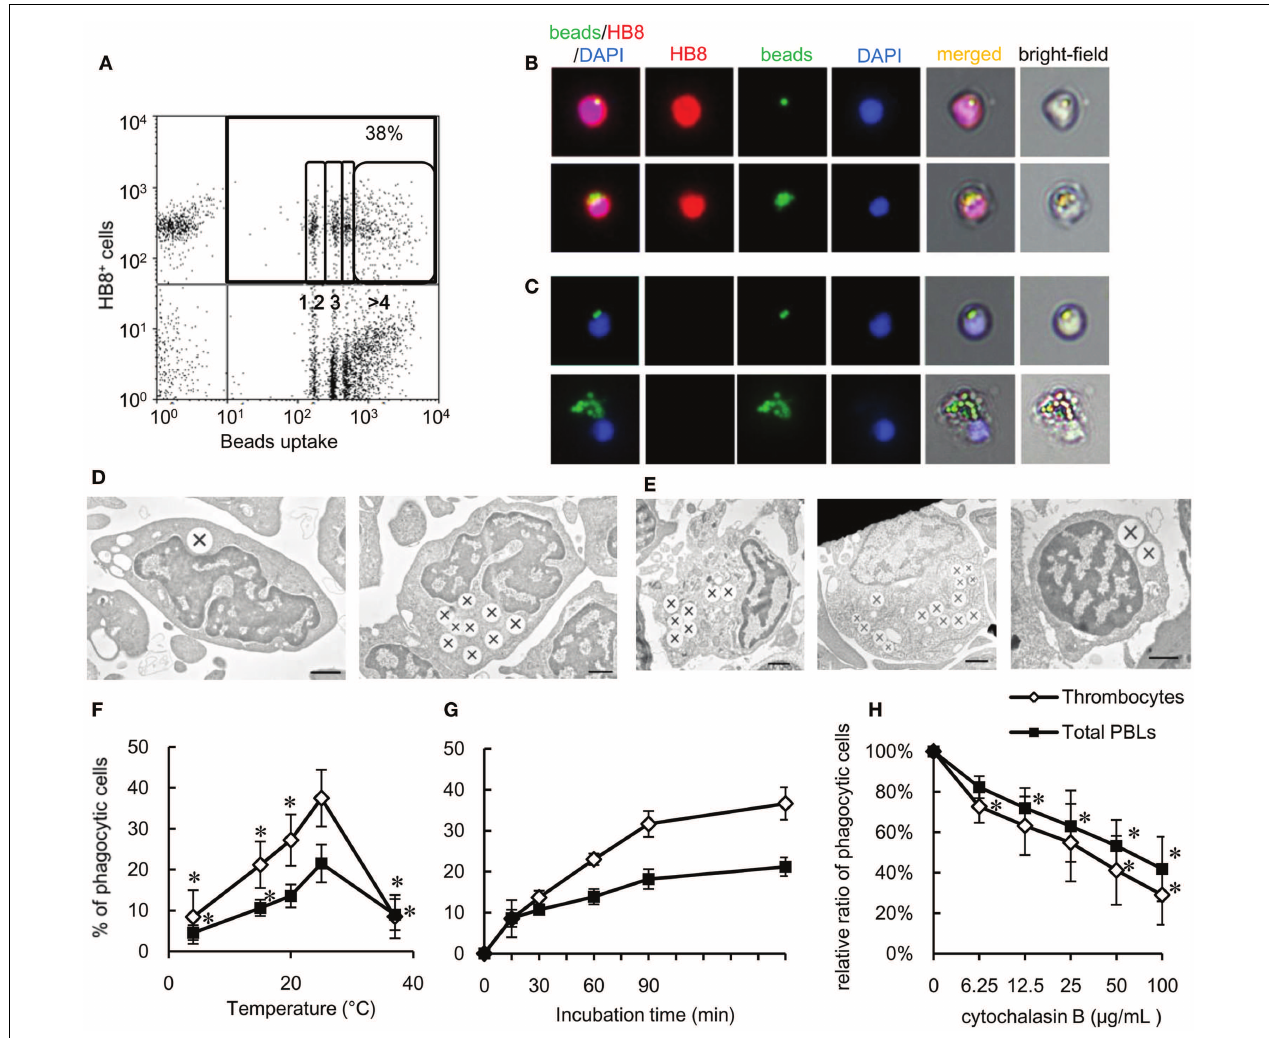
thrombocytes (D) and other phagocytes (E) incubated with beads measuring 1 µ m in diameter. Ingested beads are indicated as X. [ (E) , left] Granulocyte-like cell, [ (E) , center] monocyte-like cell, [ (E) , right] lymphocyte-like cell. Data are representative of three